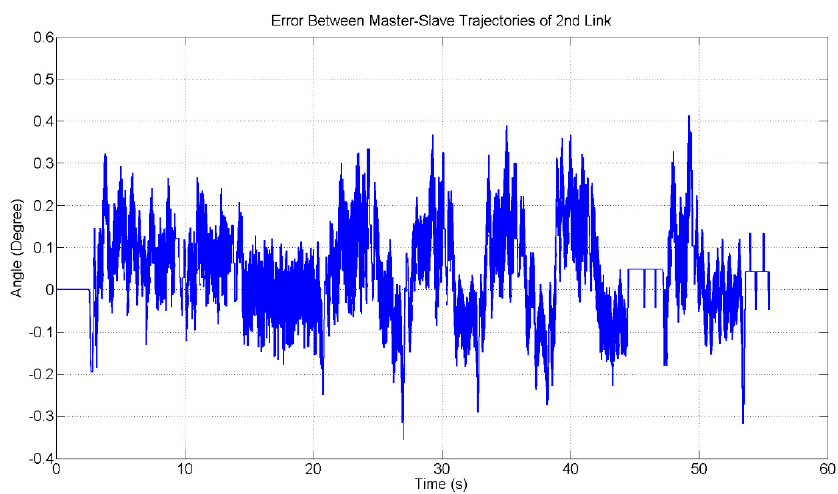
Figure 16. Master–slave trajectories for 2nd link.